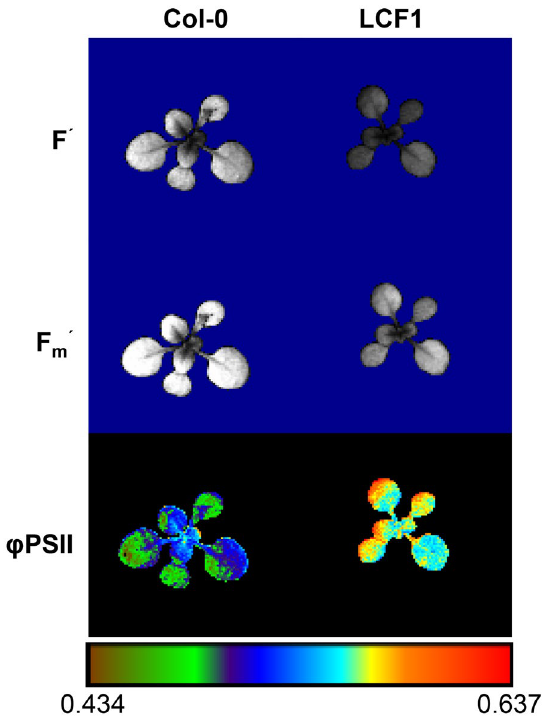
Figure 1. Overview of the chlorophyll fluorescence (CF) characteristics of Col-0 and LCF1 plants. False color images of steady state CF (F ′ ), maximal CF (F m ′ ) and the operating light use efficiency of Photosystem II ( ϕ PSII), all at 200 μ mol m − 2 s − 1 actinic